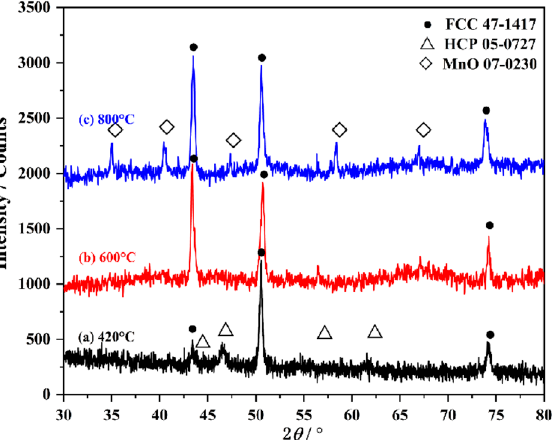
Figure 4. XRD patterns of Co 1 . 75 CrFeMnNi 0 . 25 at varying temperatures.